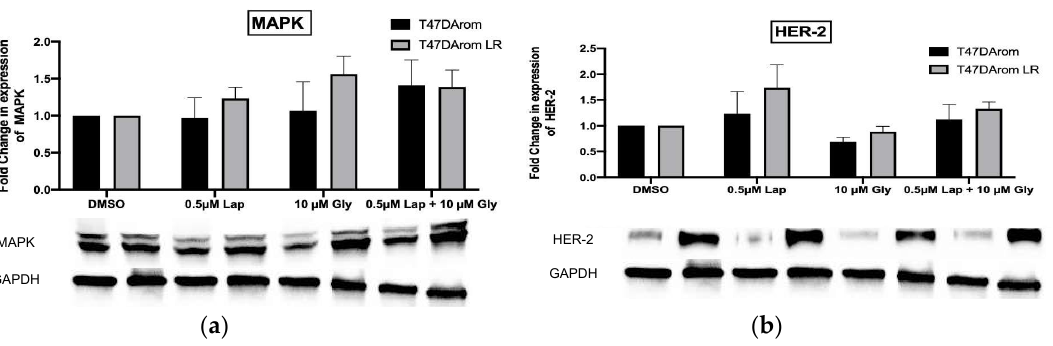
gration assays were performed using ( a ) the T47Darom cells and ( b ) the T47DaromLR breast cancer